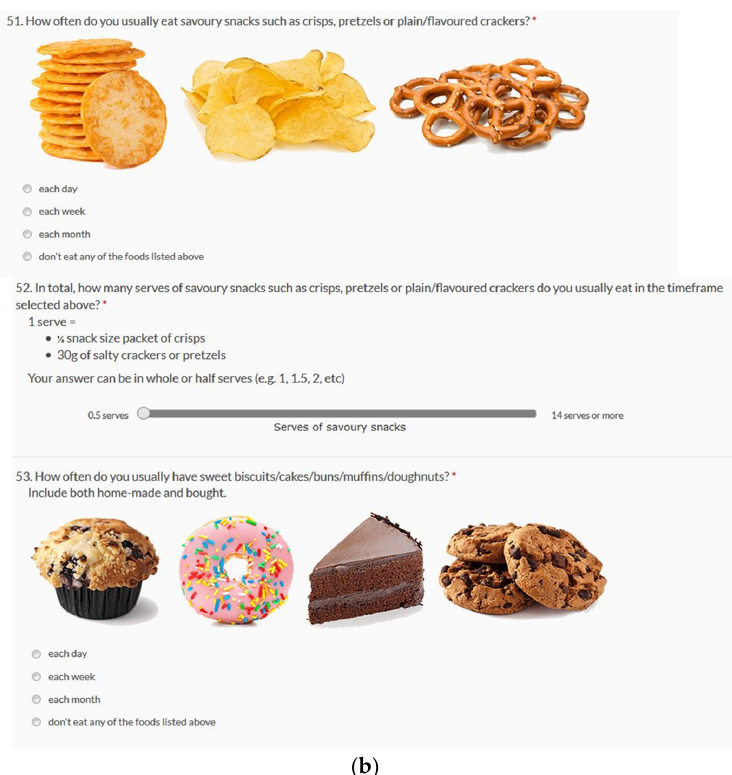
Figure 1. Screenshots of questions from the Commonwealth Scientific and Industrial Research Organisation (CSIRO) Healthy Diet Score survey. Examples of questions about the frequency and quantity of ( a ) Core foods and ( b ) Discretionary foods.